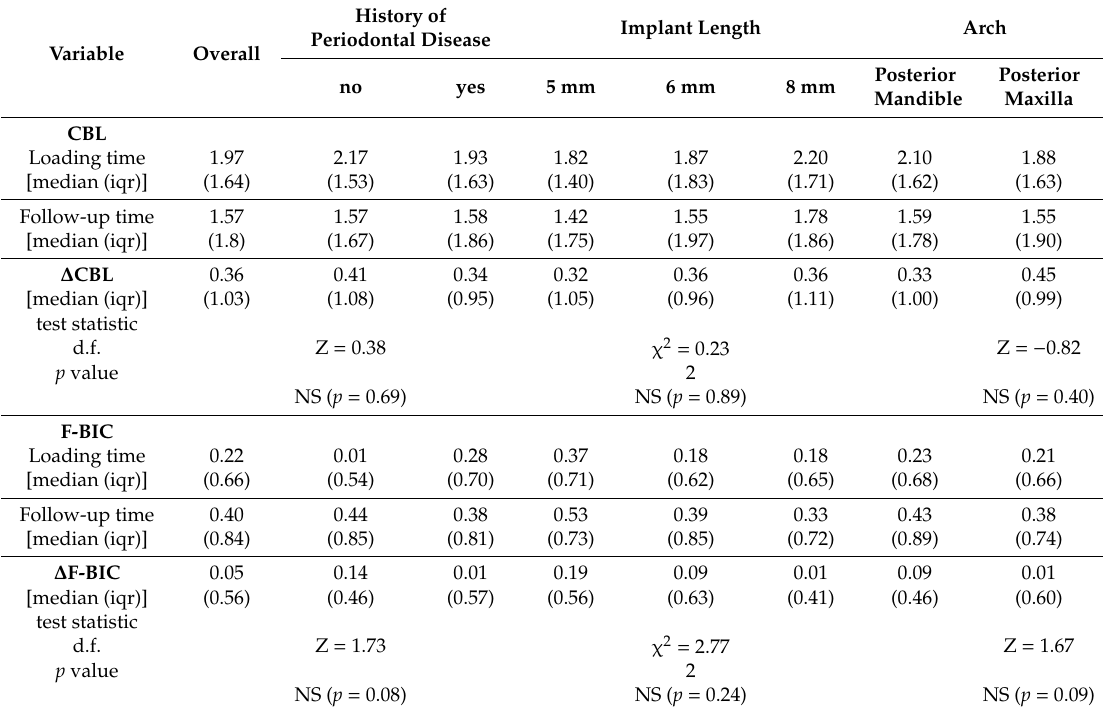
Table 4. Overall CBL / F-BIC (crestal bone level / first bone-to-implant contact) distributions and analysis of ∆ CBL / ∆ F-BIC according to PP / NPP-groups, length-groups and arch-groups. CBL / F-BIC and its variations are presented as median [iqr, interquartile range]; NS = not statistically significant; d.f. = degrees of freedom.